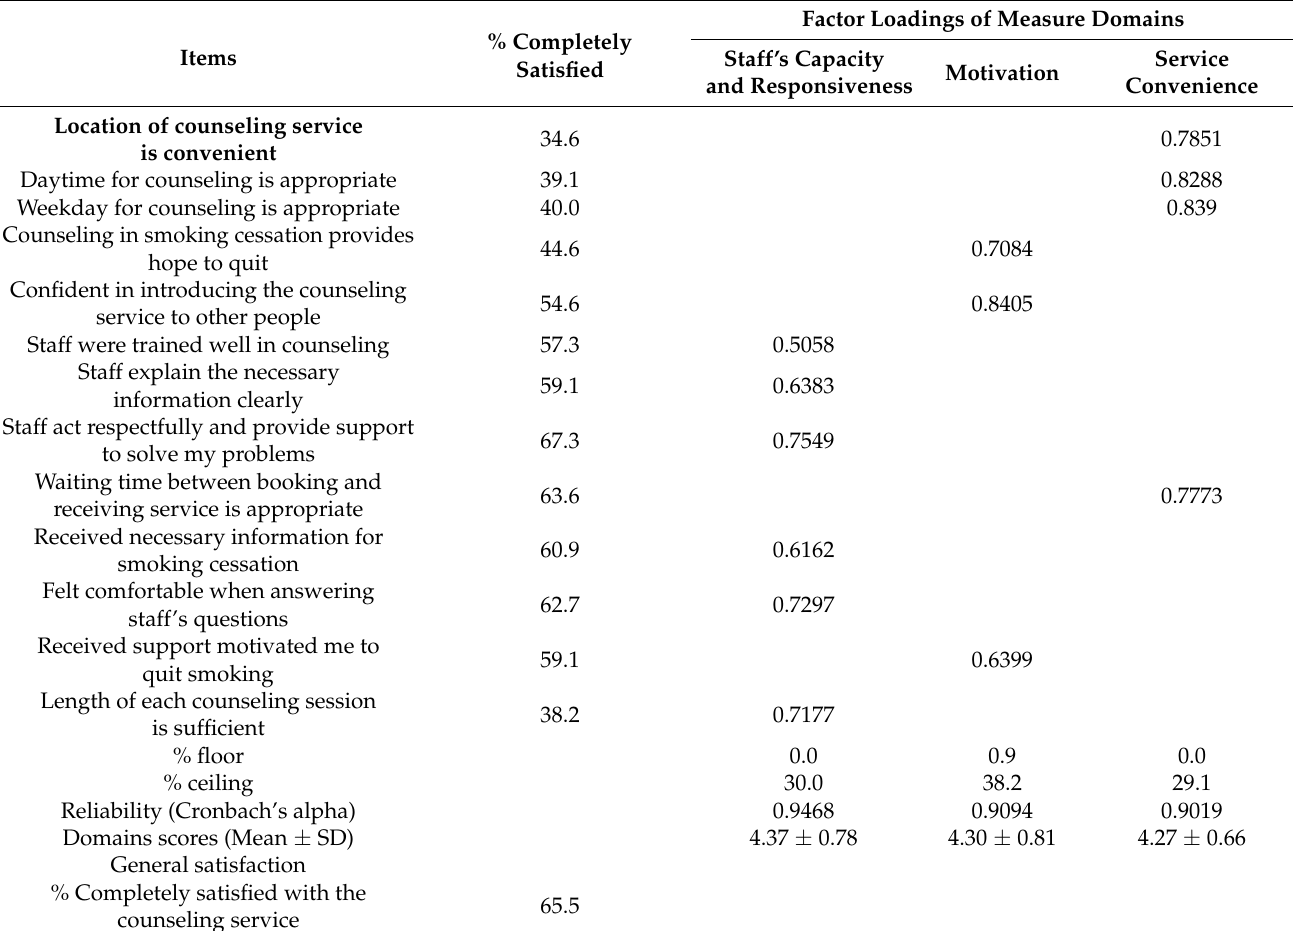
Table 4. Factor loadings of satisfaction